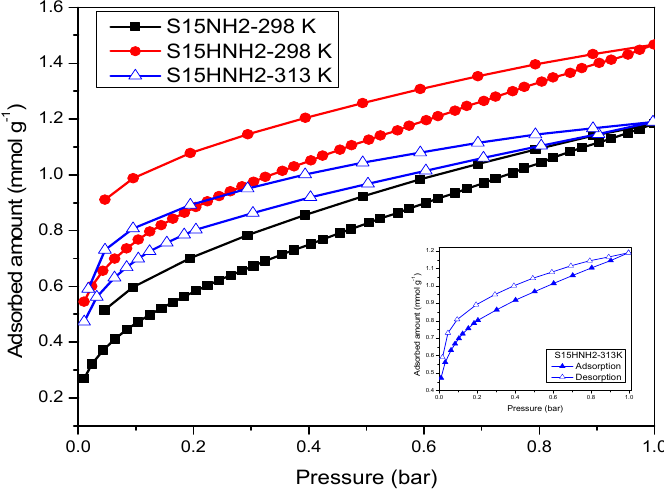
Figure 17. CO 2 adsorption isotherms at 298 K on APTES functionalized materials SBA-15 (pristine and previously treated SBA-15) and isotherm at 313 K for the sample SBA-15 hydroxylated and functionalized with APTES. In all cases the adsorption and desorption processes depict upper and lower pathways, respectively.